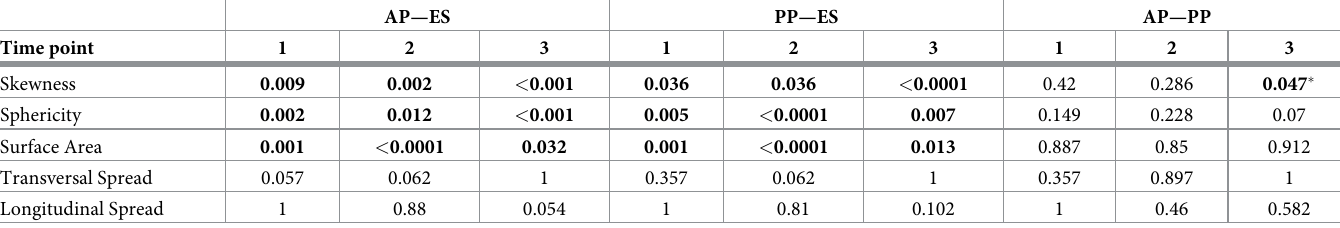
Table 1. Paired comparisons using Wilcoxon rank sum exact test ( p values–adjusted using ‘Holm’